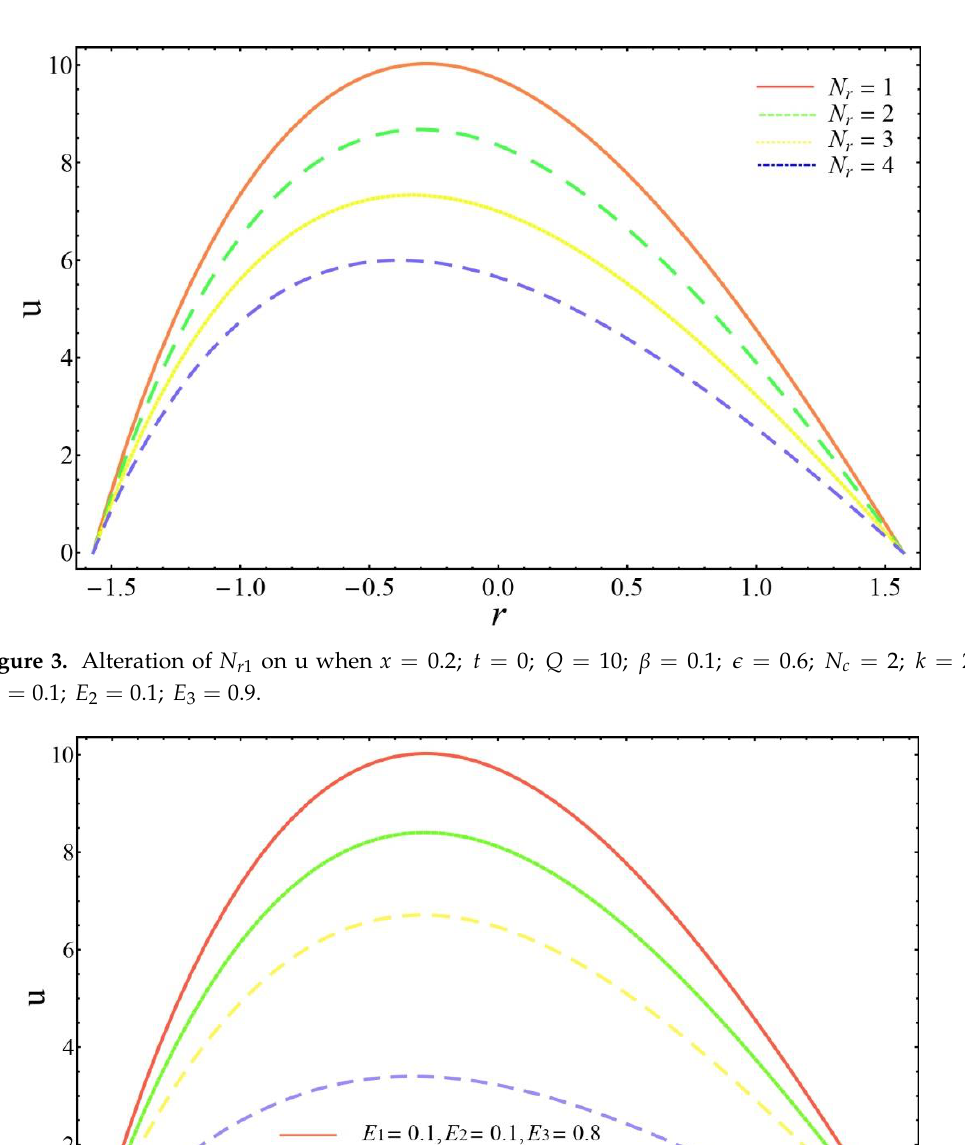
Figure 2. Alteration of 𝑁 𝑐 on u when 𝑥 = 0.2; 𝑡 = 0; 𝑄 = 10; 𝛽 = 0.1; 𝜖 = 0.6; 𝑁 𝑟1 = 2; 𝑘 = 2; 𝐸 1 = 0.1; 𝐸 2 = 0.1; 𝐸 3 = 0.9.